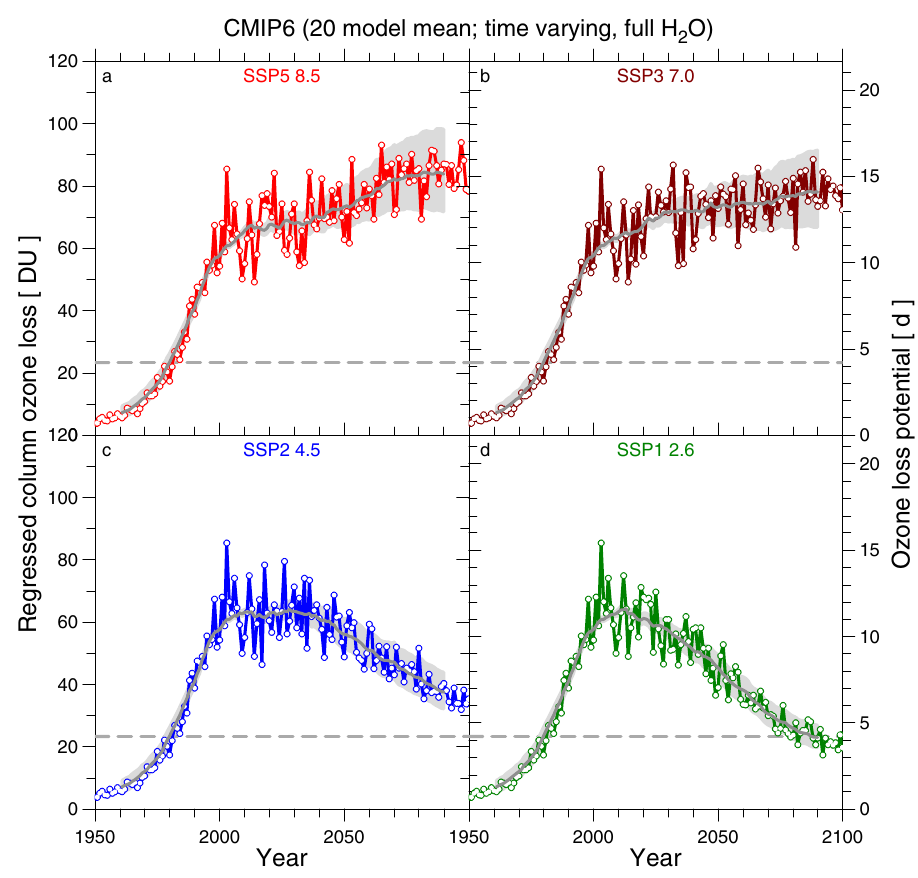
Fig. 9 Ensemble mean regressed column ozone loss and Ozone Loss Potential (OLP), variable H 2 O. Same as Fig. 8, except OLP from the archived GCM output of each GCM has been computed using the time series for polar stratospheric H 2 O shown in Fig. 2d, which accounts for increasing stratospheric humidity due to both variable CH 4 and warming of the tropical tropopause. a SSP5-8.5, b SSP3-7.0, c SSP2-4.5, and d SSP1-2.6